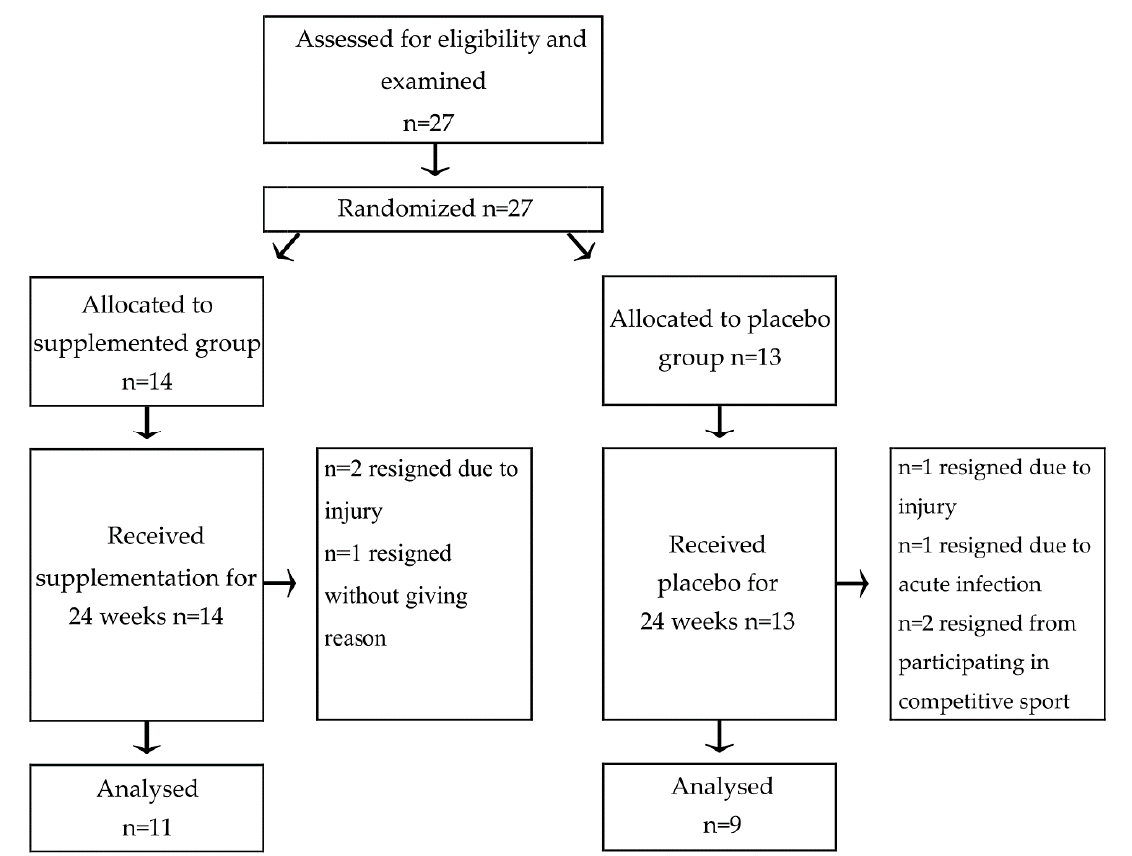
Figure 1. Recruitment process of participants to the trial.